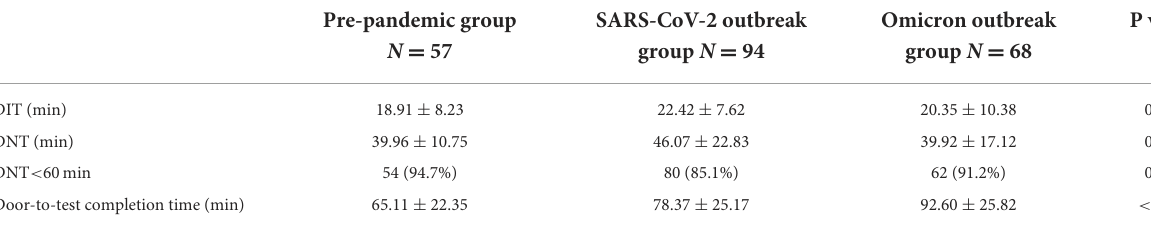
TABLE 2 Comparisons of in-hospital delay indicators in the three groups of patients undergoing intravenous